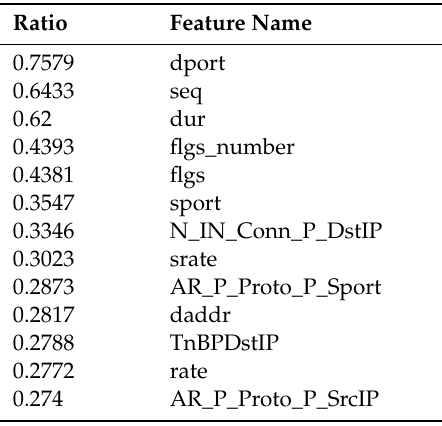
Table 7. Information gain for di ff erent features.